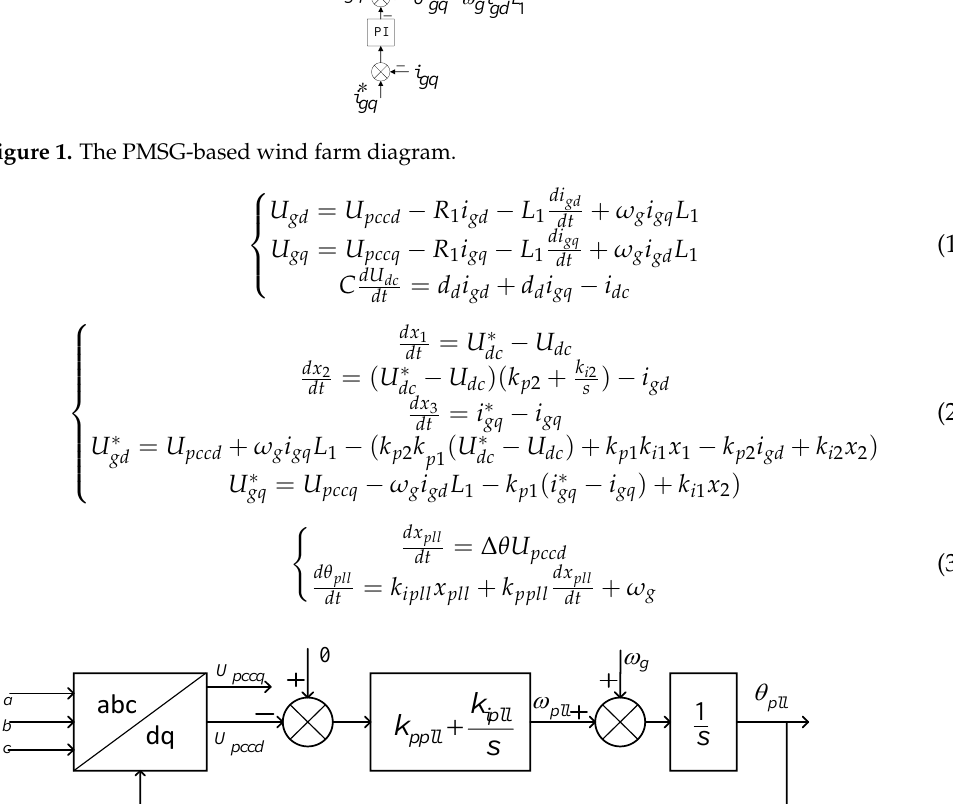
, i ∗ , i dc )), and its state gq dc